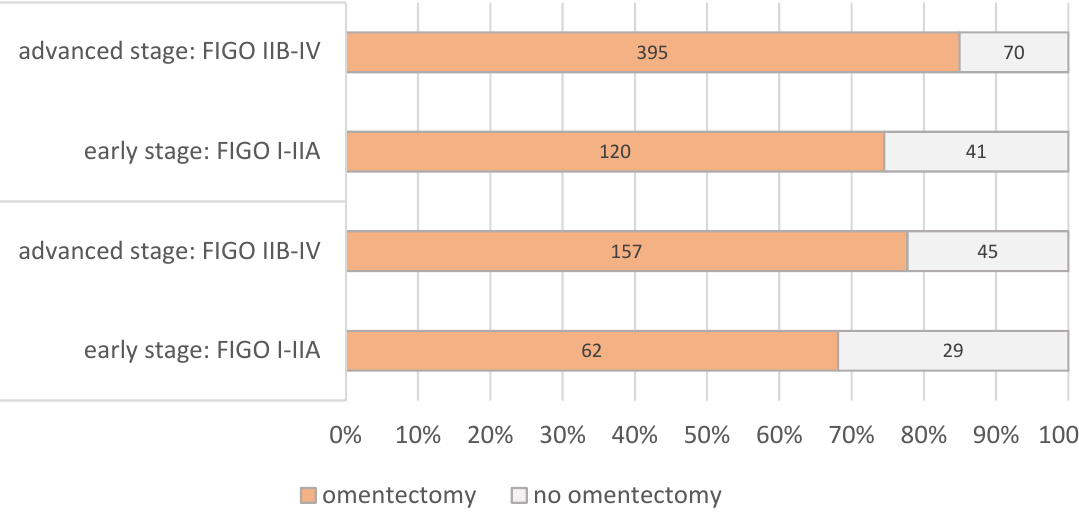
Figure 3. Proportion of patients with primary ovarian cancer with and without systematic pelvic and paraaortic lymphadenectomy according to FIGO stage ( n = 919, years 2016–2018).